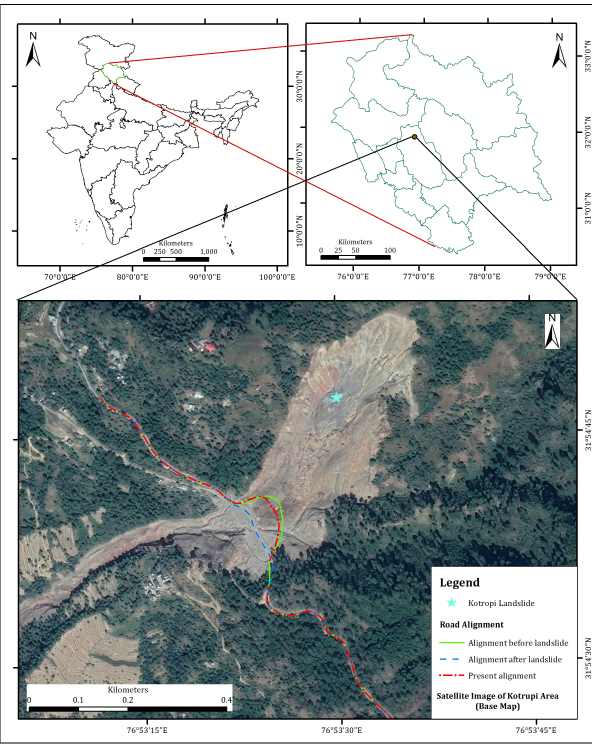
Figure 1. Kotrupi landslide location as seen on satellite images. The present road alignment, before landslide and change in alignment soon after the landslide are shown with red, green and blue lines